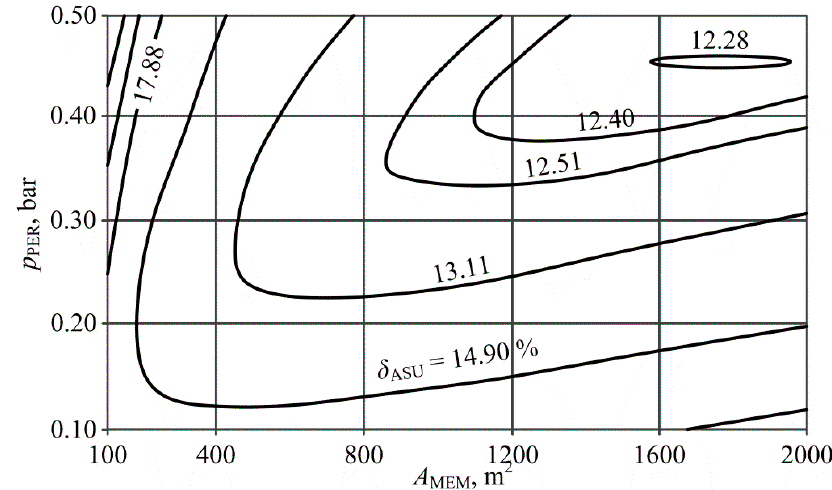
Figure 9. Variant V2 ASU auxiliary power as a function of permeate pressure and the membrane’s surface area.